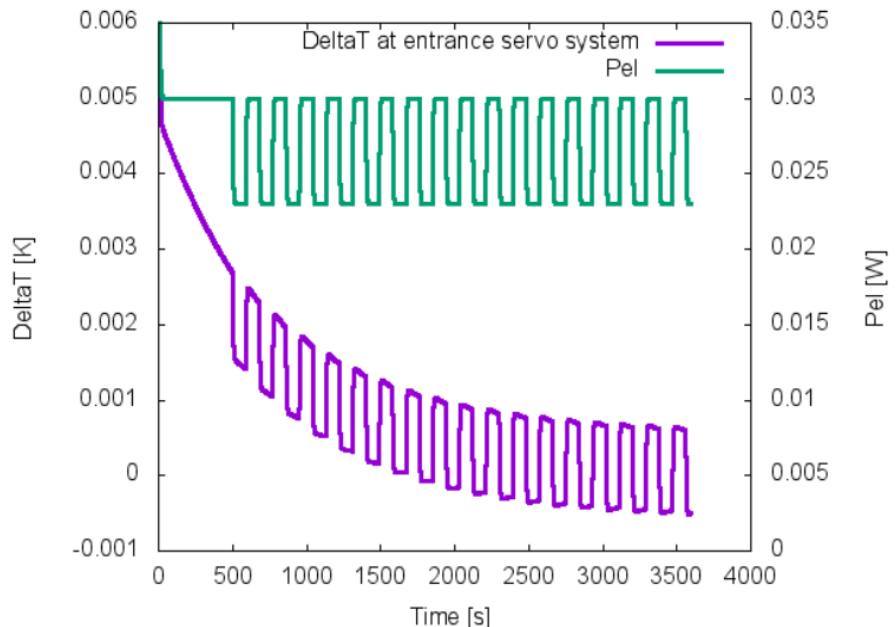
Figure 11. Shuttered servo system, where an optical power of 7 mW is applied after 500 s. Purple curve, left scale: temporal evolution of the temperature error signal at the entrance of the servo system. Green curve, right scale: temporal evolution of the electrical